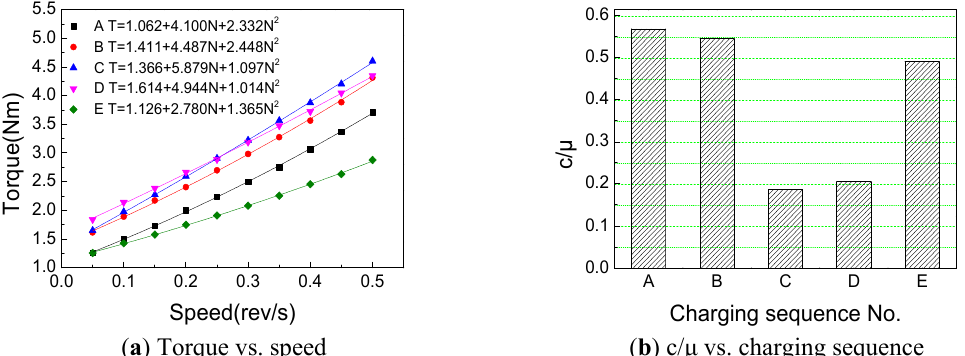
Figure 4. Effect of charging sequence on the shear thickening behaviour of SCC. Figure 4. E ff ect of charging sequence on the shear thickening behaviour of SCC.